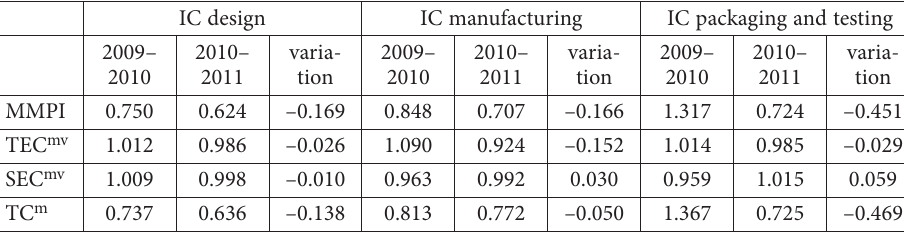
Table 8. The time trend of GMPI and MMPI from 2009 to 2011 IC